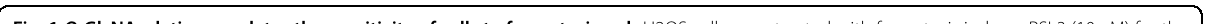
Fig. 1 O -GlcNAcylation regulates the sensitivity of cells to ferroptosis. a , b U2OS cells were treated with ferroptosis inducer RSL3 (10 μ M) for the indicated time. O -GlcNAcylation levels were detected by immunoblotting with antibodies against O -GlcNAc and β -actin ( a ), and the relative intensity ( O -GlcNAc/ β -actin) was quanti fi ed ( b ). Cell viability was measured by CCK8 ( b ). Lipid ROS production was assessed by BODIPY 581/591 C11 staining followed by fl ow cytometry ( b ). c , d U2OS cells were treated with OSMI-1 (30 μ M) or TMG (10 μ M) for 12 h, and then induced with or without RSL3 for 6 h. Cells were stained with Trypan blue solution ( c ) and the percentages of dead cells were quanti fi ed ( d ). e U2OS cells were treated with OSMI-1 or TMG for 12 h, and then induced with or without RSL3 for 3 h. Cells were stained with PI and assessed by fl ow cytometry. f U2OS cells were incubated with DMSO or OSMI-1 for 12 h and then pre-treated with Fer-1 for 2 h before the treatment of RSL3 for 4 h. Cells were stained with PI and cell death was then assessed by fl ow cytometry. g U2OS cells were transfected with control or OGT siRNAs for 48 h, and then treated with RSL3 for 3 h before being assessed by PI staining by fl ow cytometry. h U2OS cells were transfected with control or OGT siRNAs for 48 h and then pre-treated with Fer-1 for 2 h before the treatment of RSL3 for 6 h. Cells were stained with Trypan blue and the percentages of dead cells were quanti fi ed. i , j U2OS ( i ) or HT29 cells ( j ) were incubated with OSMI-1 or TMG for 12 h followed by co-treatment of increasing concentrations of RSL3 for 3 h. Dose-dependent cell viability was measured by CCK8 (OD 450). k – n U2OS or HT29 cells were pre-incubated with OSMI-1 or TMG for 12 h followed by co-treated with RSL3 (10 μ M for U2OS,1 μ M for HT29) for 2 h. Lipid ROS production was assessed by BODIPY 581/591 C11 staining followed by fl ow cytometry (Ex/Em: 488/510nm for the oxidized dye). o U2OS cells were treated with DMSO (Control) or OSMI-1 for 12 h, and then treated with RSL3 for different time as indicated. Cells were then subjected to immuno fl uorescence microscopy with antibodies against TfR1 and GM130. All experiments were repeated at least three times. Scale bars, 10 μ m unless speci fi cally indicated. *** P < 0.001, **** P < 0.0001. Error bars indicate